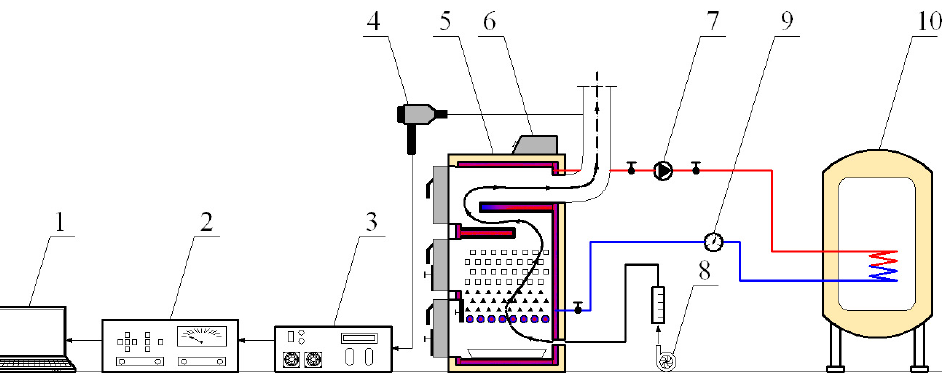
Figure 1. Diagram of measuring system: 1—computer, 2—NDIR gas analyzer, 3—dryer flue gas, 4—probe, 5—boiler, 6—microprocessor-based controller boiler, 7—pump, 8—air fun, 9—water flow rate meter, 10—heat exchanger receiving thermal energy from the boiler. Source: own study.